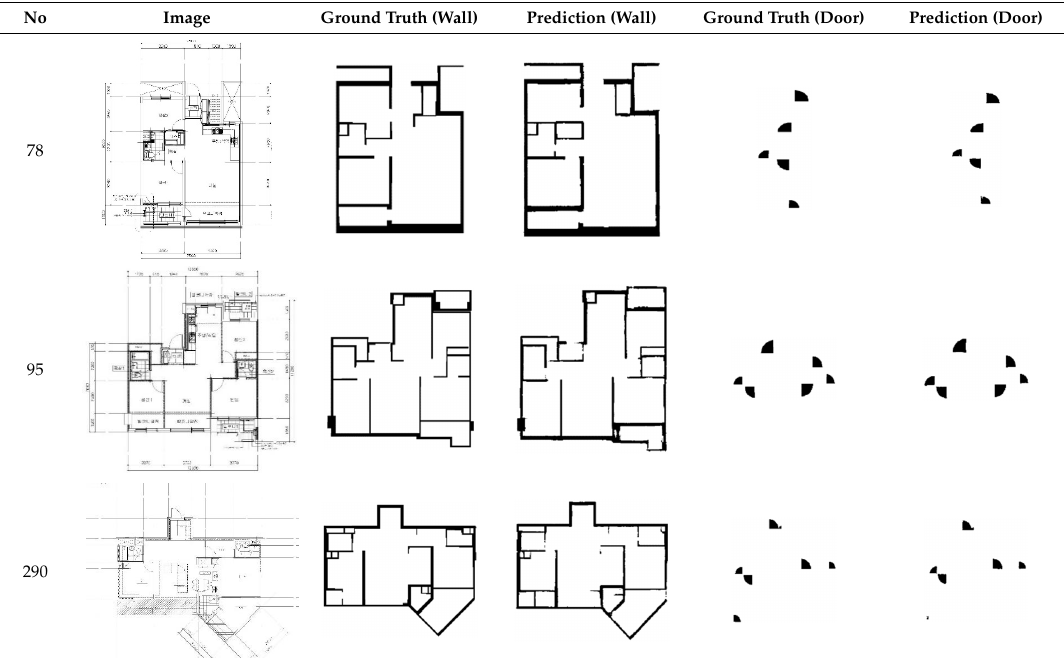
Table 5. Wall and door segmentation results.